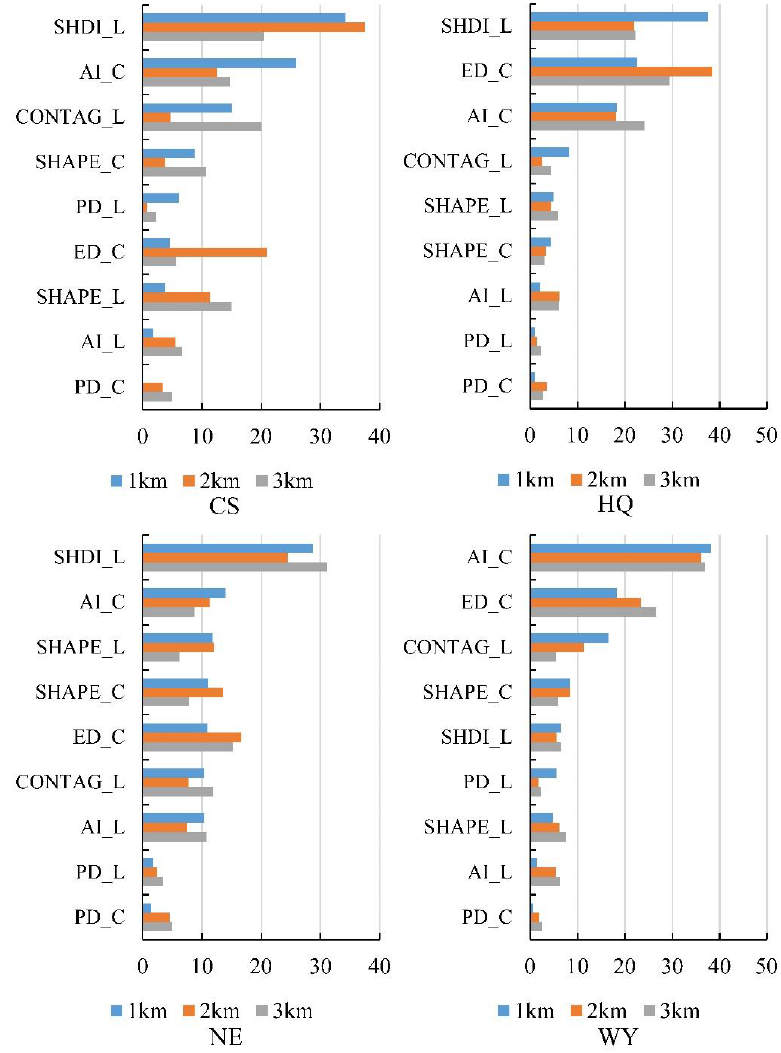
Figure 3. Relative importance values of selected landscape metrics at the landscape level and class level for ecosystem services. Metrics with the suffix ‘_L’ represent landscape pattern metrics at the landscape level. Metrics with the suffix ‘_C’ represent landscape pattern metrics at the class level.